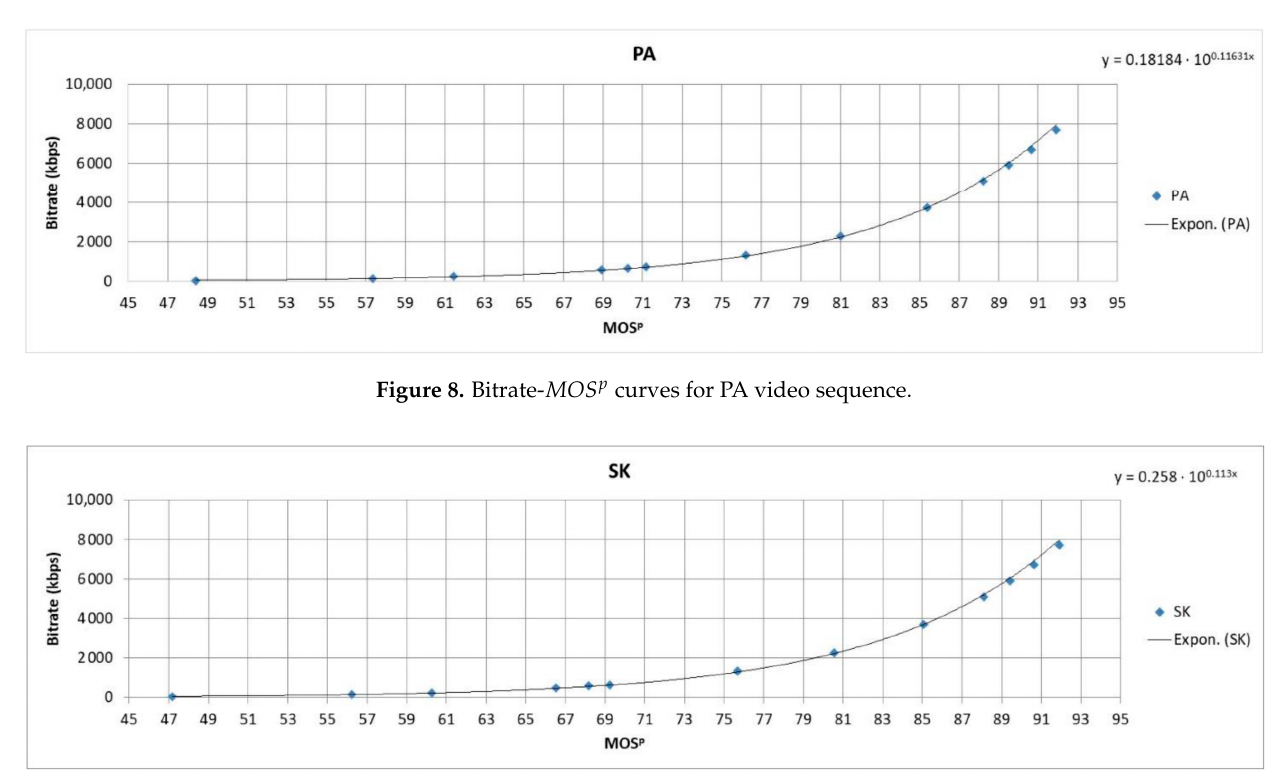
Figure 7. Bitrate- 𝑀𝑂𝑆 (cid:3043) curves for C47 video sequence.